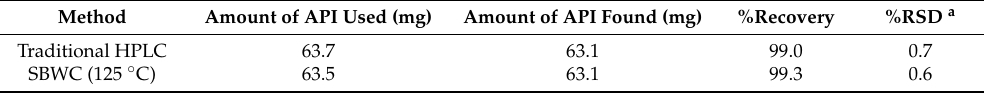
Table 2. Comparison of aspirin quantification results achieved by traditional HPLC and